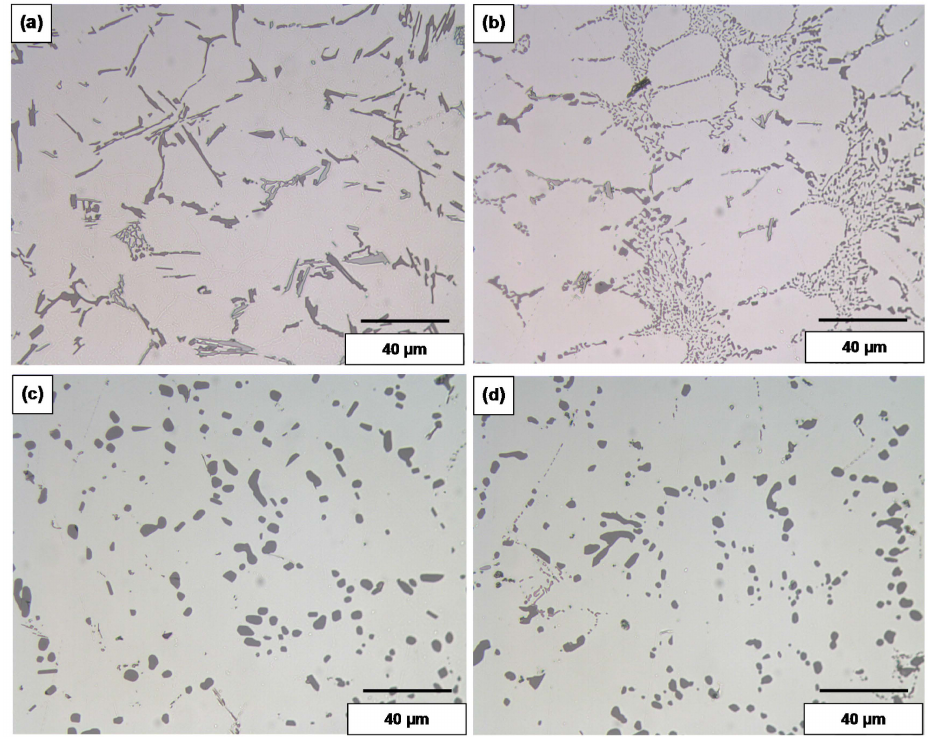
Figure 7. Morphology of eutectic silicon particles observed in the 357 alloys under the following conditions: ( a ) and ( c ) are the base alloy A1 in the as-cast and solution heat-treated conditions, respectively; ( b ) and ( d ) are A1BS alloy in the as-cast and solution heat-treated conditions, respectively, DAS of 25 µ